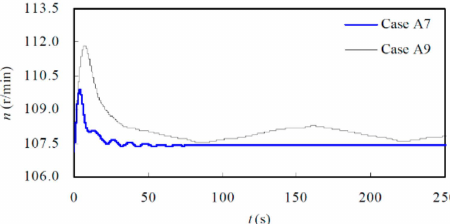
Figure 26. Time histories of rotational speed under load disturbance. Reproduced with permission from [44], ASME,